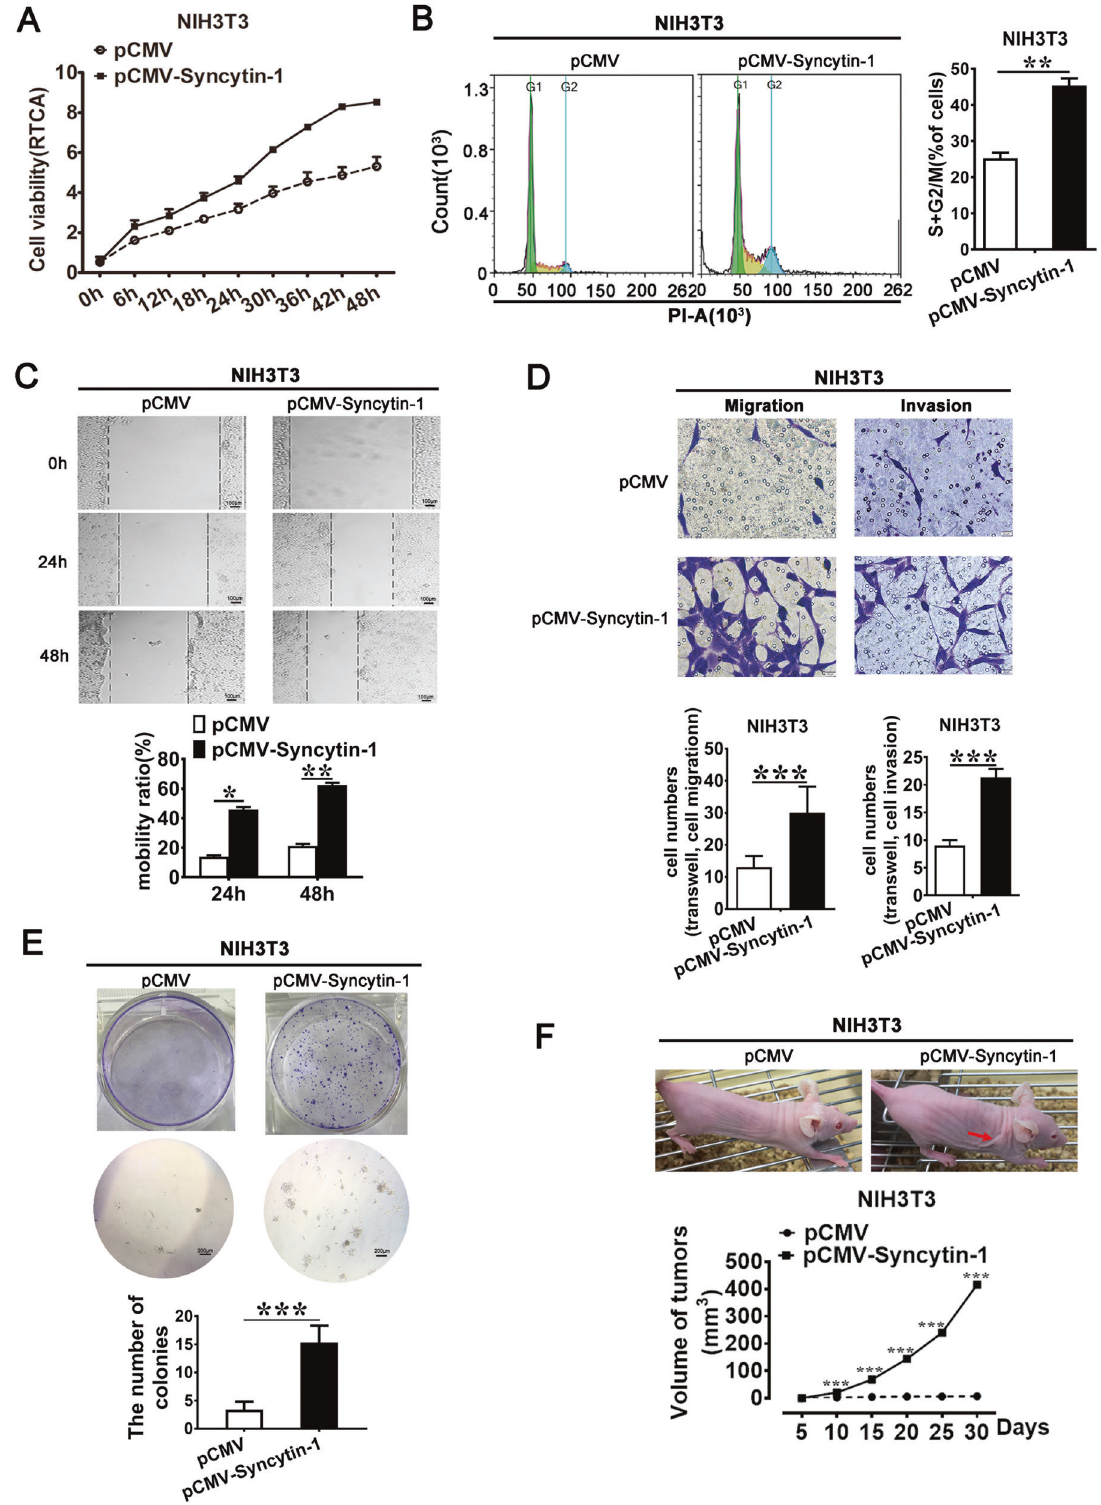
Fig. 3 Syncytin-1 promotes cell marinization in NIH3T3 cells. a The effect of Syncytin-1 on cell proliferation was examined by RATC assay. b Variation of the cell cycles in Syncytin-1 overexpressed NIH3T3 cells was determined by fl ow cytometry. c The effect of Syncytin-1 on cell migration ability was assessed using the wound healing assay. d The effects of Syncytin-1 on cell migration and invasion were detected. e Foci formation assay was used to reveal the role of Syncytin-1 on cell transformation in NIH3T3. f Tumor xenograft assay. Arrows indicate the formation of xenograft tumors in nude mice. The graph shows the mean ± SEM of tumor volume induced by Syncytin-1-transfected NIH3T3 cells. All graphs represent at least three independent experiments. *** p < 0.001.